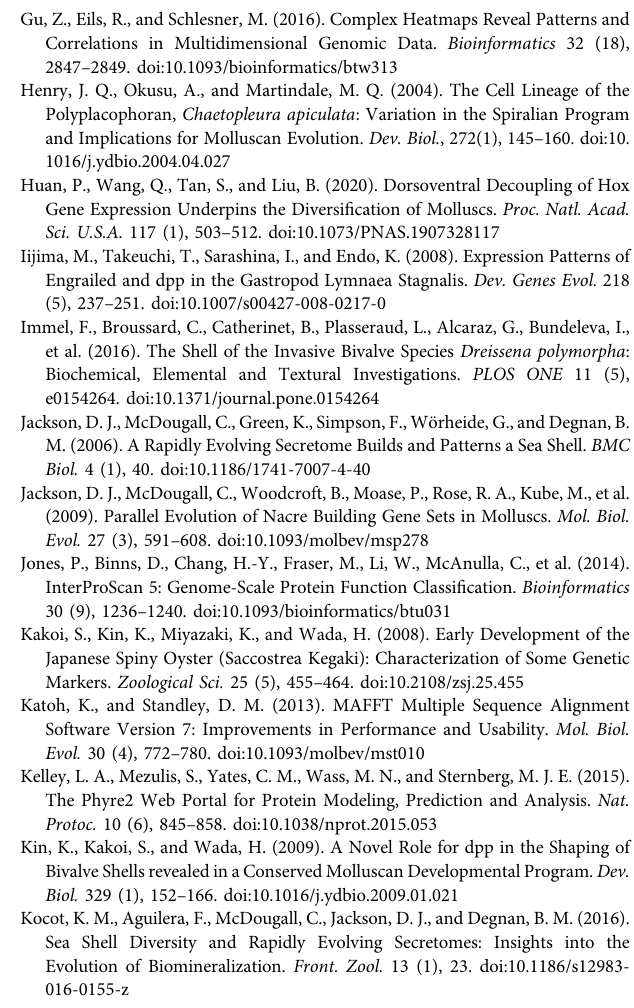
on Zhao et al. (2018)]. Supplementary Table S9 | Annotations of shell-related genes from Crassostrea gigas. Results from annotations of shell protein matrix genes taken from Zhao et al. (2018). Each column corresponds to annotations assigned in Zhao et al. (2018). Indicated is the gene code from the NCBI database, the result of the analysis performed on the aminoacid sequence showing the presence of transmembrane domains and signal peptides, and the assigned signature description. Supplementary File S1 | Output generated from the Phyre2 webserver. Summary results and fi les are in pdb format for the predicted tertiary structure of each